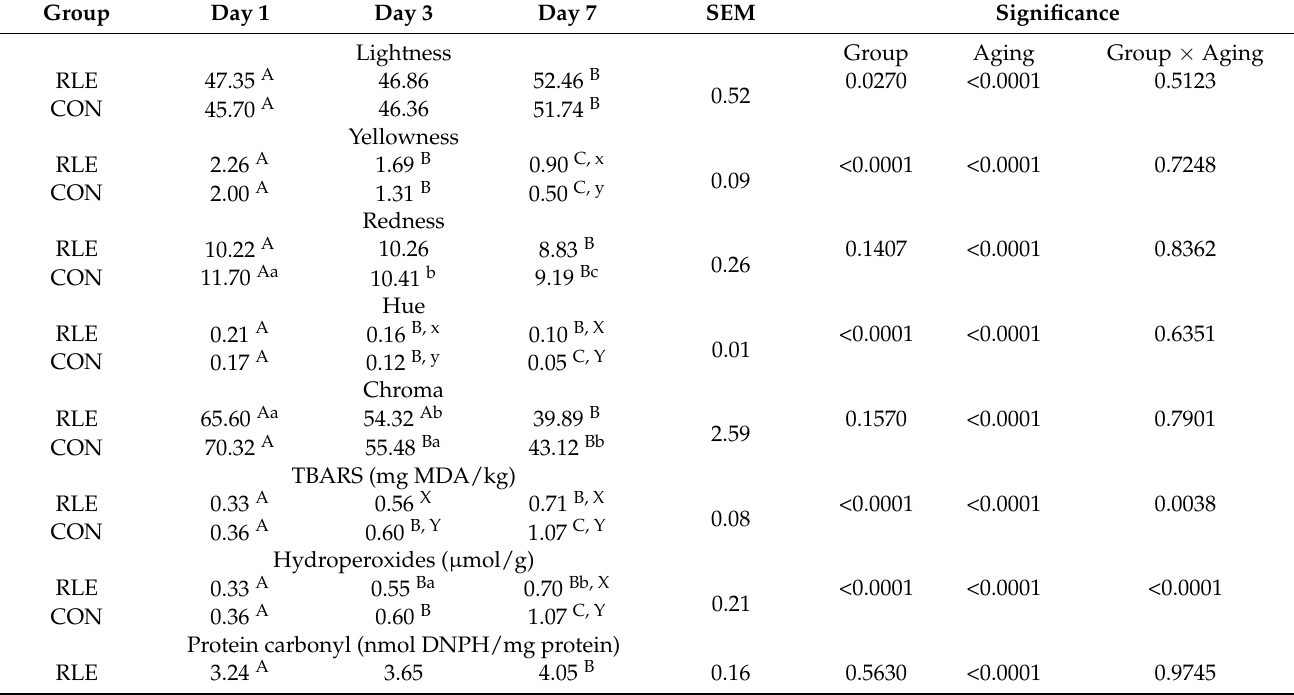
Table 5. Effect of including anthocyanins in the diet and of aging time on kid’s meat color and oxidative parameters. Group Day 1 Day 3 Day 7 SEM Significance Lightness Group Aging Group × Aging